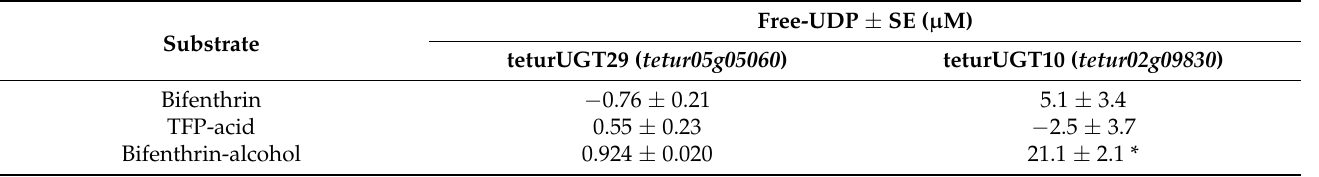
* indicates a significant ( p adj < 0.05) difference between the mean of bifenthrin-alcohol and the means of TFP-acid and bifenthrin in combination with teturUGT10, as determined by one-way ANOVA with post-hoc Tukey.